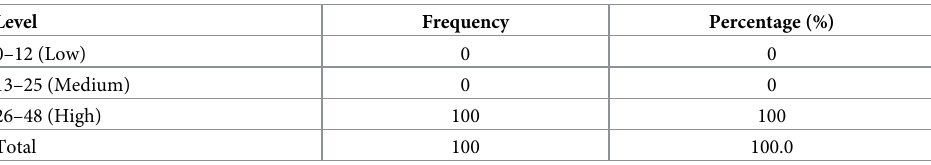
Table 4. Level of understanding of wet nursing in Islamic